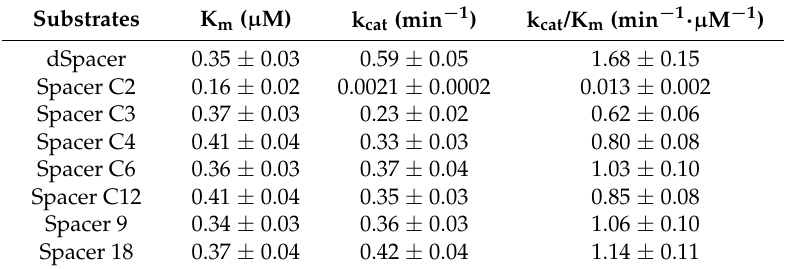
Table 1. Kinetic parameters K m and k cat of TeuendoIV for AP-site